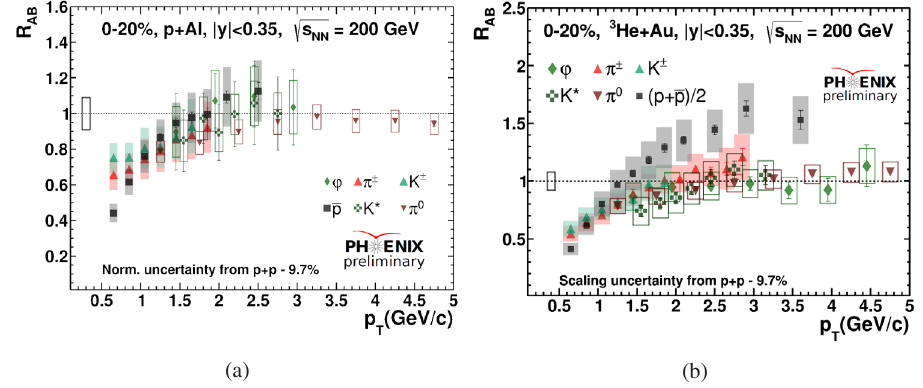
Figure 1: The comparison of φ meson to ⇡ 0 , ⇡ ± , K ± , K ⇤ and p ( ¯ p ) nuclear modification factors in (a) p + Al and (b) 3 He + Au collisions at p s The normalization uncertainty from p + p ( bars correspond to statistical errors and rectangles – to systematic ones. The box near unity corresponds to the normalization